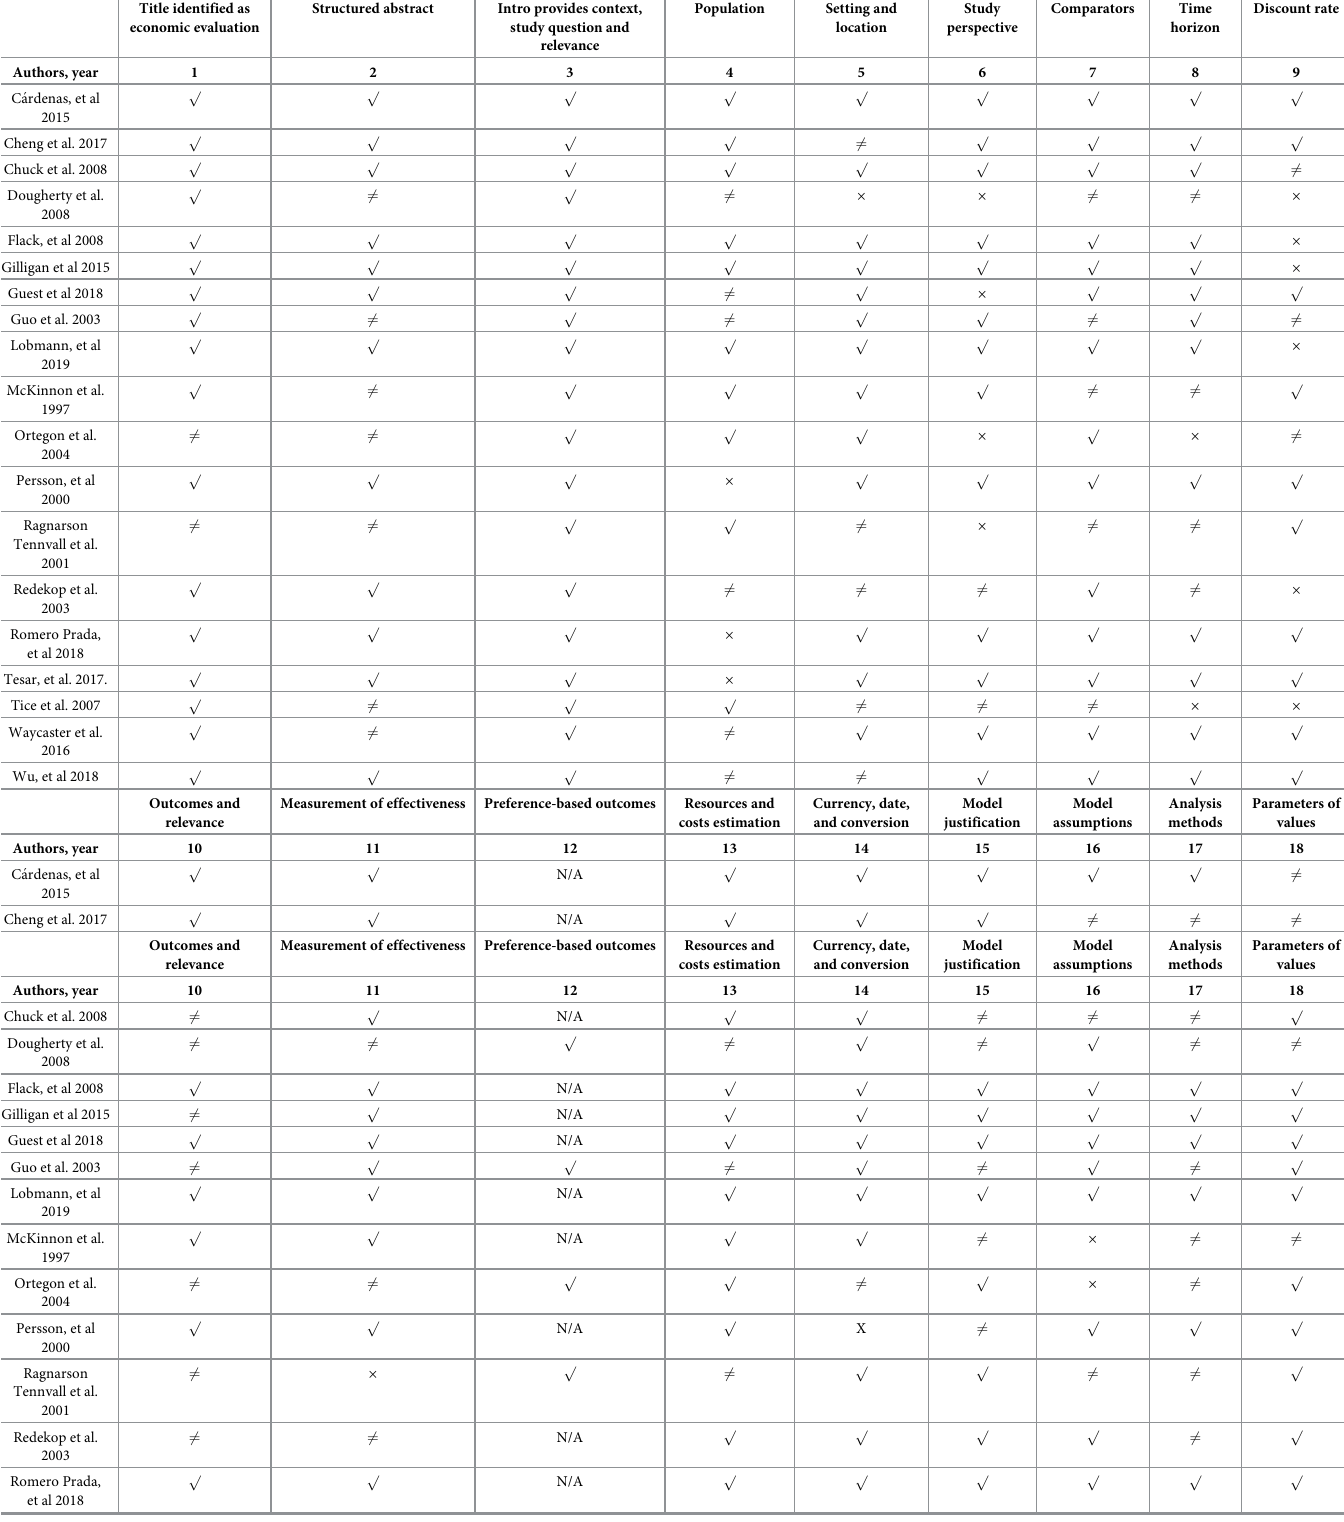
Table 3. Quality assessment of publications against the Consolidated Health Economic Evaluations Reporting Standards (CHEERS)